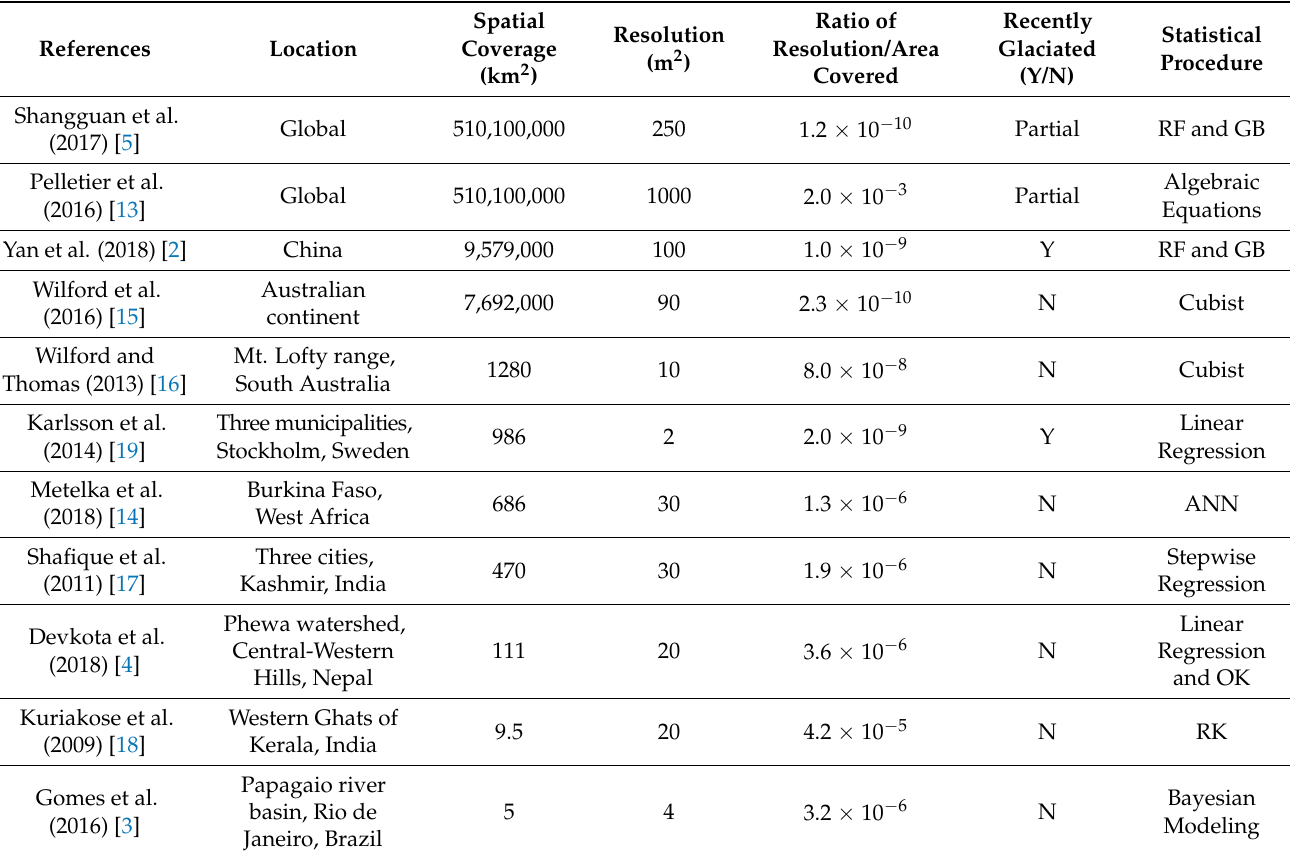
Table 1. Comparison of reviewed literature for predicting overburden depth-to-bedrock, DTB, where RF = Random Forest, GB = gradient boosting, ANN = artificial neural network, OK = ordinary kriging, and RK = regression